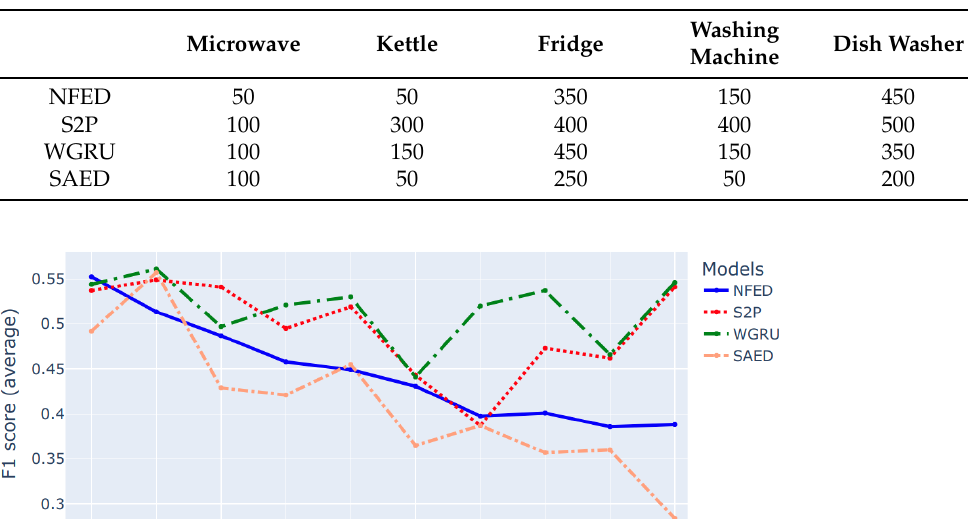
Table 2. A map of the models under evaluation with the respective best window length for each appliance.